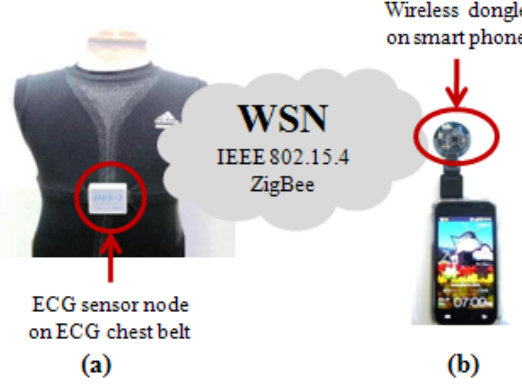
Figure 3. Deployment of sensor nodes in WSN: ( a ) Wearable health shirt embedded with ECG devices; ( b ) Wireless dongle on smart phone